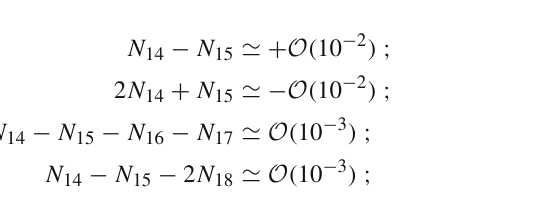
column, we list the estimates for the resonance model of ref. [28], keep- ing the parameters f V , g V and f A and setting α V = 0 = α A , for a meaningful